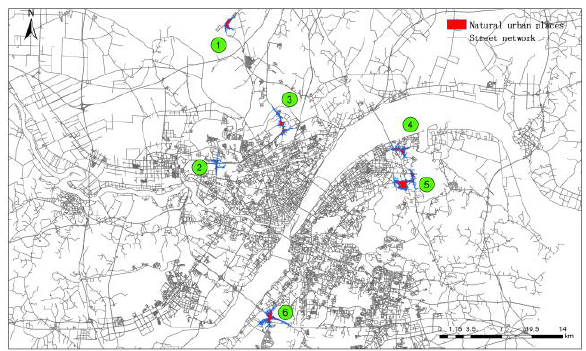
Figure 3. Selection of natural urban places for functionality